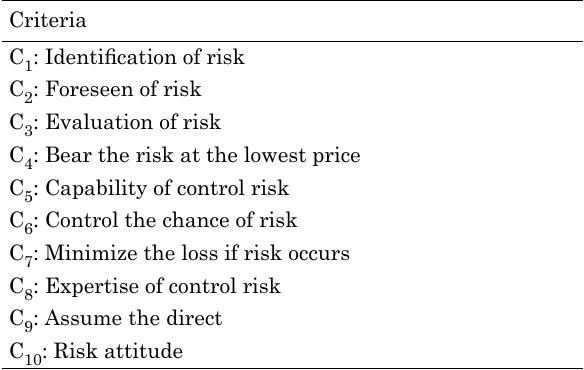
Table 5. Significant risk allocation criteria in Iranian PPP project Criteria